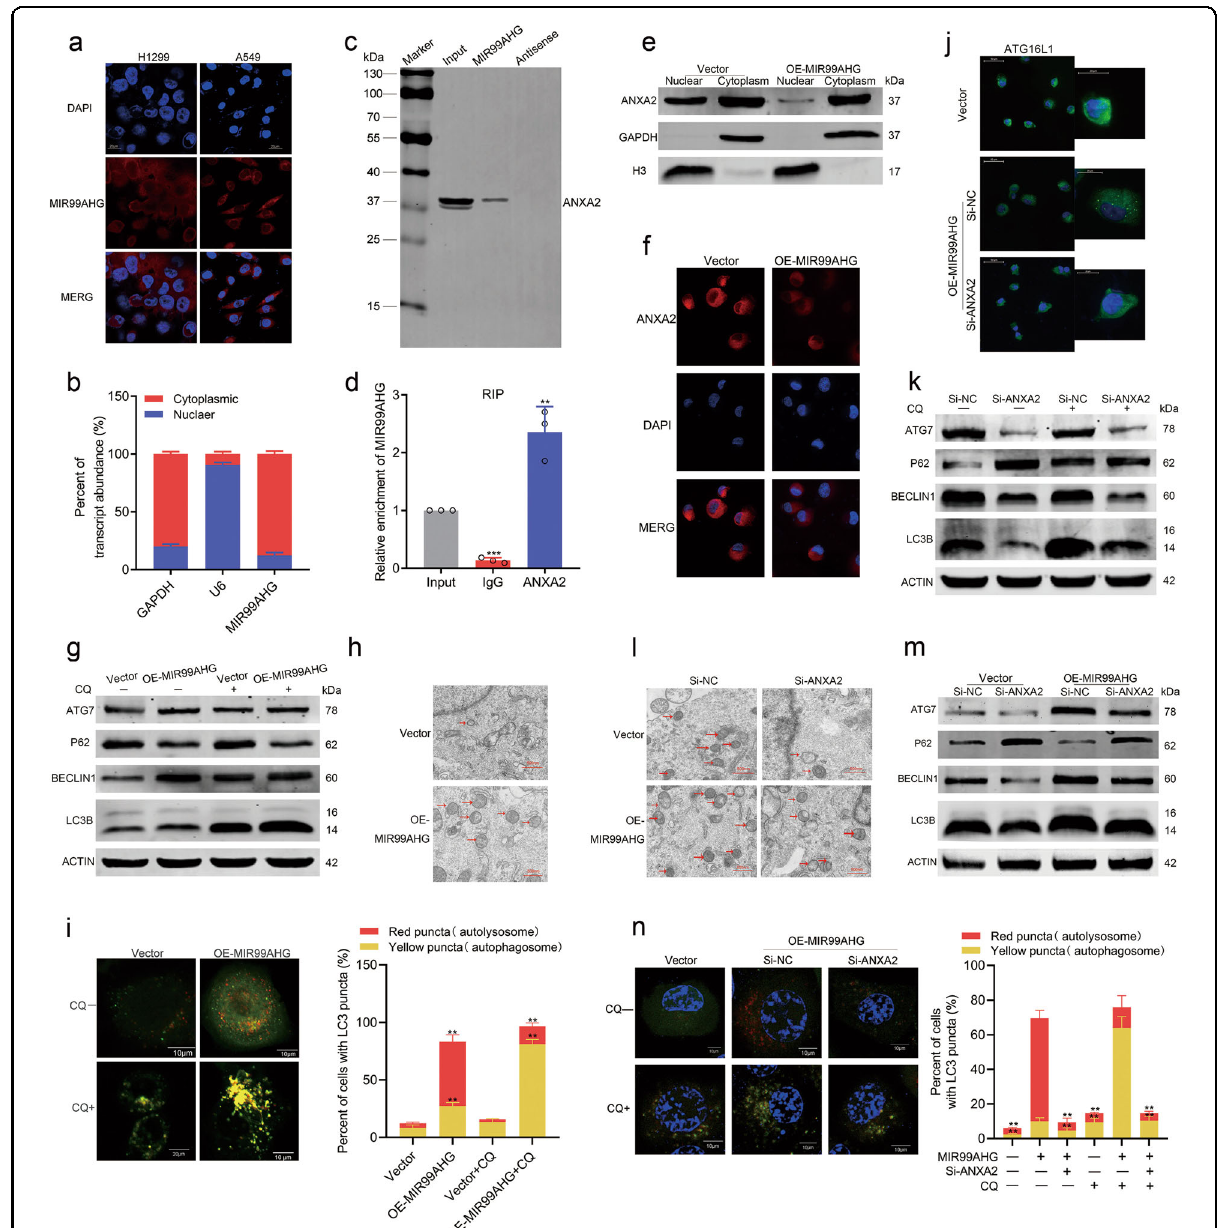
Fig. 5 MIR99AHG binds ANXA2 and keeps ANXA2 in the cytoplasm, thus promoting autophagy of H1299 cells. a and b MIR99AHG was mainly located in the cytoplasm according to FISH ( a ) and nuclear mass separation assays ( b ). c In vitro transcription and pull-down assays showed that biotinylation-MIR99AHG could retrieve ANXA2. The antisense of MIR99AHG was used as a negative control. d RNA immunoprecipitation (RIP) experiments for ANXA2 were performed and the coprecipitated RNA was subjected to qRT-PCR for MIR99AHG. IgG was used as a negative control. e Subcellular fractionation of H1299 cells. Histone H3 and GAPDH served as nuclear and cytosol-speci fi c markers, respectively. f Immuno fl uorescent analysis of changes induced by MIR99AHG overexpression in ANXA2 subcellular localization of H1299 cells. g Western blot (WB) analyses indicated the expression changes of autophagy-related proteins (LC3 conversion, ATG7, p62, and Beclin-1) in the indicated cells in the absence ( − ) or presence ( + ) of chloroquine treatment. h Ultrastructural evidence of autophagy induced by enforced MIR99AHG expression in H1299 cells. Red arrows indicate autophagosomes or autolysosomes. i Detection of autophagic fl ux with the mRFP-GFP-LC3 reporter in response to overexpression of MIR99AHG. The percentages of cells showing accumulation of yellow or red puncta were calculated. j Immuno fl uorescence assays demonstrated that MIR99AHG enhanced ATG16L + vesicle formation in H1299 cells. k – n Autophagy level changes in H1299 cells induced by transfection as indicated were shown by WB assays ( k , l ), TEM ( m ) and autophagy fl ux experiments ( n ). All experiments were repeated three times with similar results and images are representative of three independent experiments. A two-tailed Student ’ s t -test was used for statistical analysis. * P < 0.05, ** P < 0.01, *** P < 0.001. Error bars, SEM.